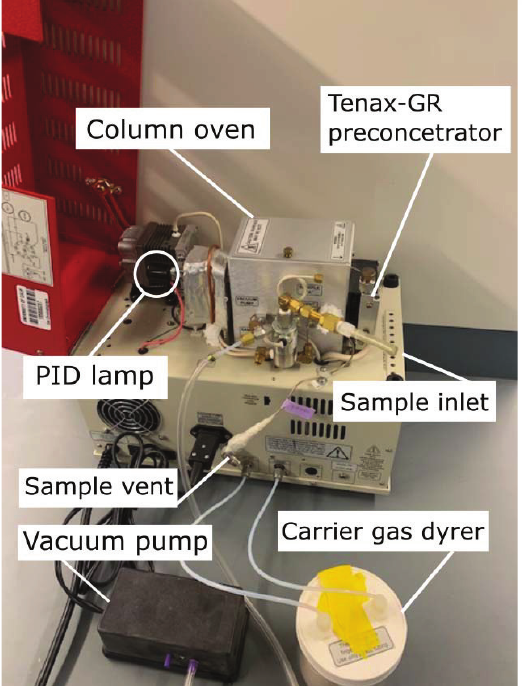
Figure 1. Side view of the compact benzene, toluene, ethylbenzene, and xylene isomers (BTEX) compact gas chromatograph with photoionization detector (GC-PID) prototype. The system has an ultra-compact chassis (SRI 110 chassis model) weighing 15 kg with dimensions of 36.8 × 21.6 × 34.3